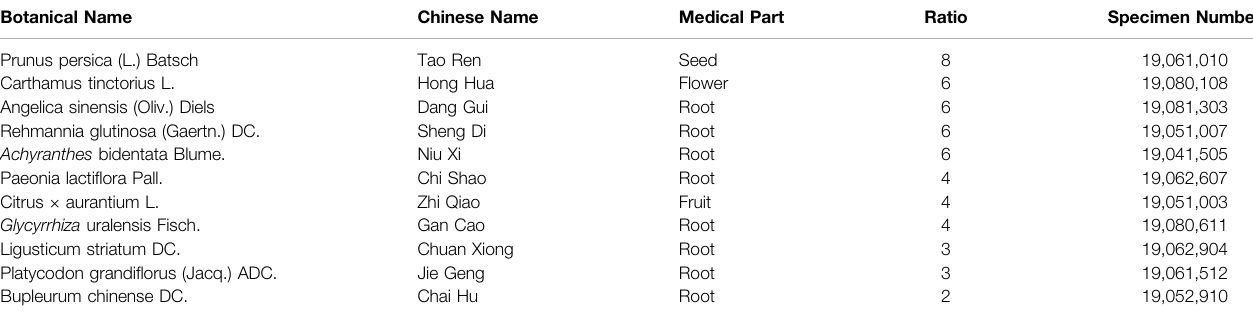
TABLE 1 | Composition of xuefu zhuyu decoction